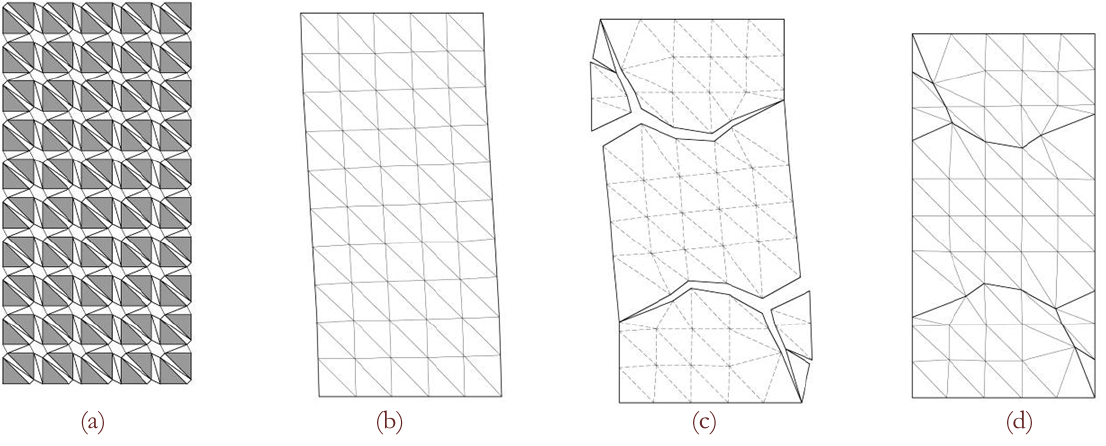
Figure 13: Sheared and stretched strip. Original mesh (a), starting state (b), deformed shape at convergence (c), final mesh at convergence